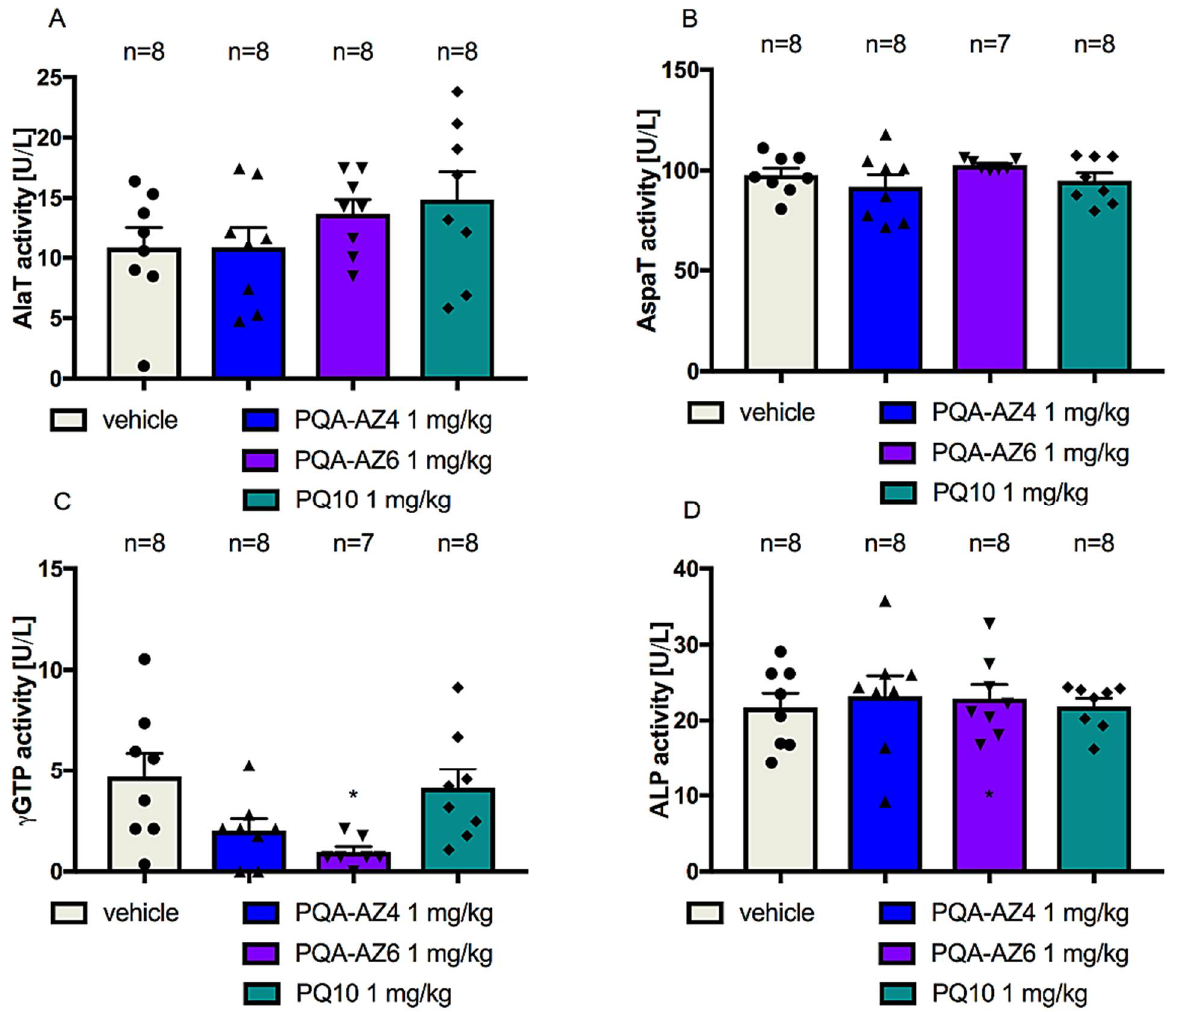
Figure 7. Effects of repeated administration of PQA-AZ4, PQA-AZ6, and PQ-10 on activities of enzymes: alanine aminotransferase (AlaT, ( A )), aspartate aminotransferase (AspaT, ( B )), gamma-glutamyltransferase ( γ GTP, ( C )), and alkaline phosphatase (ALP, ( D )) in serum. PQA-AZ4, PQA-AZ6, and PQ-10 were administered i.p. once daily for 21 consecutive days. Data represent the mean ± SEM, n = 7–8 rats per group; statistical analysis was performed using the Student’s t -test, * p < 0.05 vs. respective vehicle-treated group.